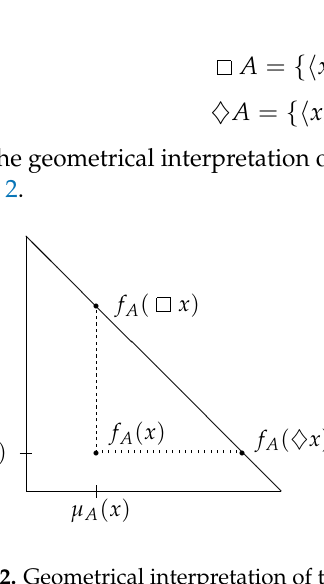
Figure 2. Geometrical interpretation of the two intuitionistic fuzzy modal